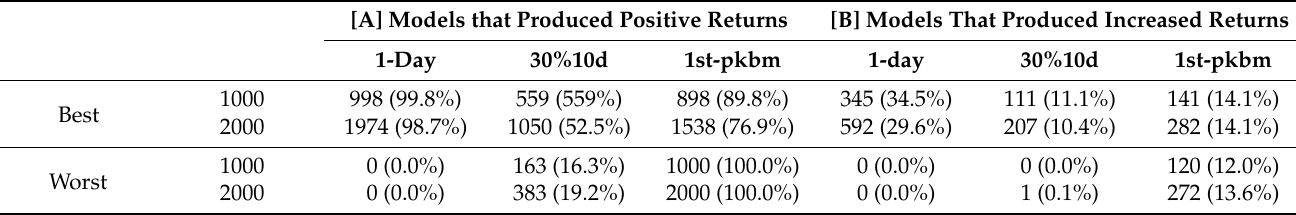
Table 11. Results after Applying the Three Strategies to the Top and Bottom Ranked MACD Models. [A] Models that Produced Positive Returns [B] Models That Produced Increased